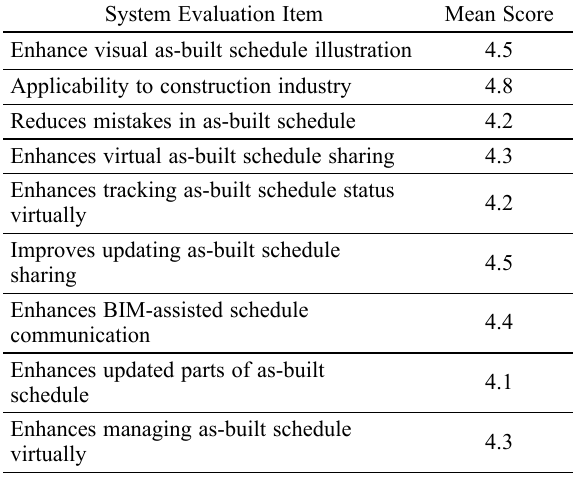
Table 1. System evaluation result